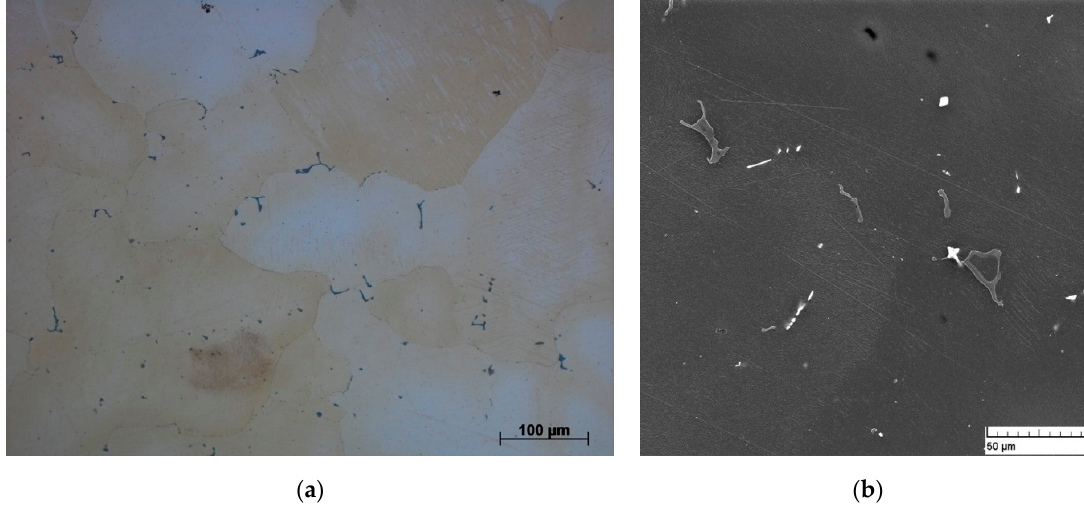
Figure 2. Microstructure of the AZ31 alloy after heat treatment. ( a ) Light micrograph. ( b ) Electron micrograph. Picric acid was used for etching.